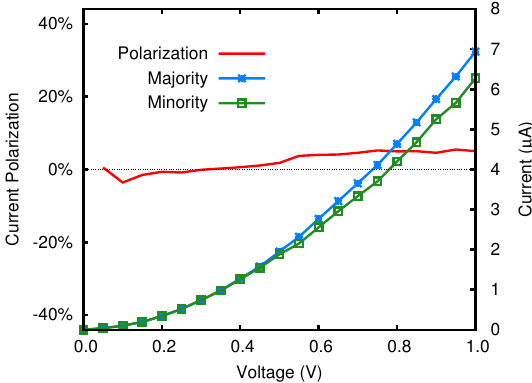
Figure 5. I ( V ) curve in the FeP